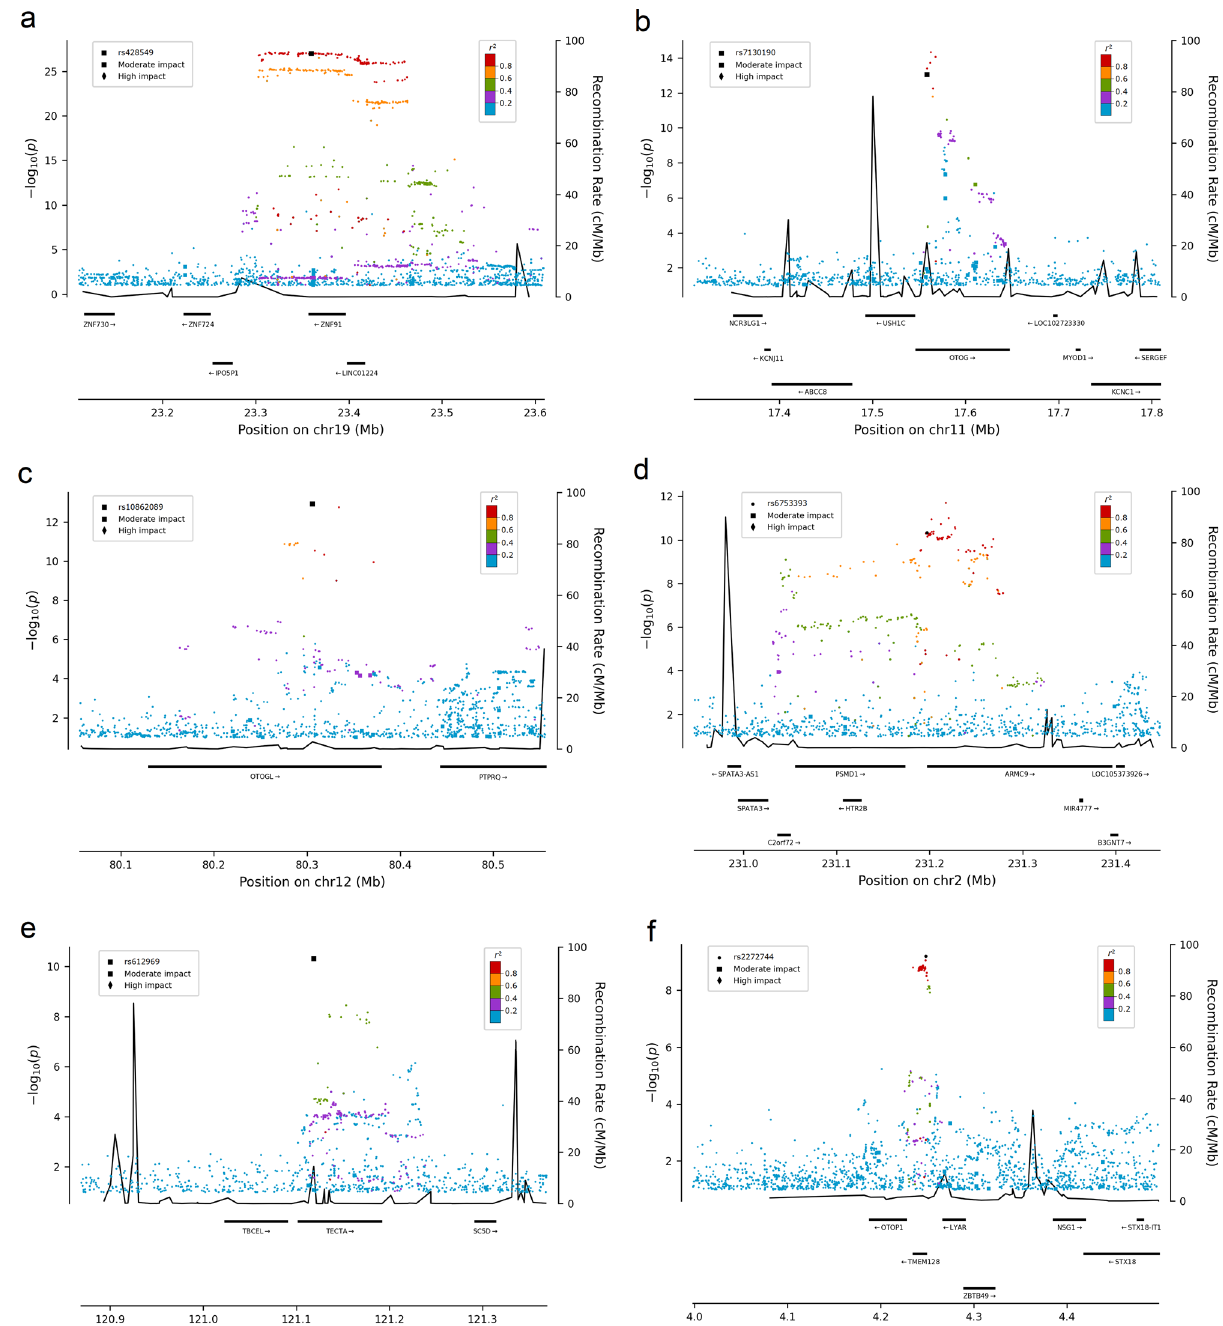
Fig. 2 Regional plot of the loci associating with vertigo. Regional plots representing the association with vertigo in the meta-analysis at the a ZNF91 locus, b OTOG locus, c OTOGL locus, d ARMC9 locus, e TECTA locus, and f OTOP1 locus. Variants are colored by the degree of correlation ( r 2 ) with the lead variant, which is colored black. Functional variants have a squared (moderate impact) or a diamond shape (high impact). The − log 10 P values on the left y - axis (two-sided logistic regression) are plotted for each variant against their chromosomal position ( x -axis). The right y -axis shows calculated recombination rates based on the Icelandic data at the chromosomal location, plotted as solid black